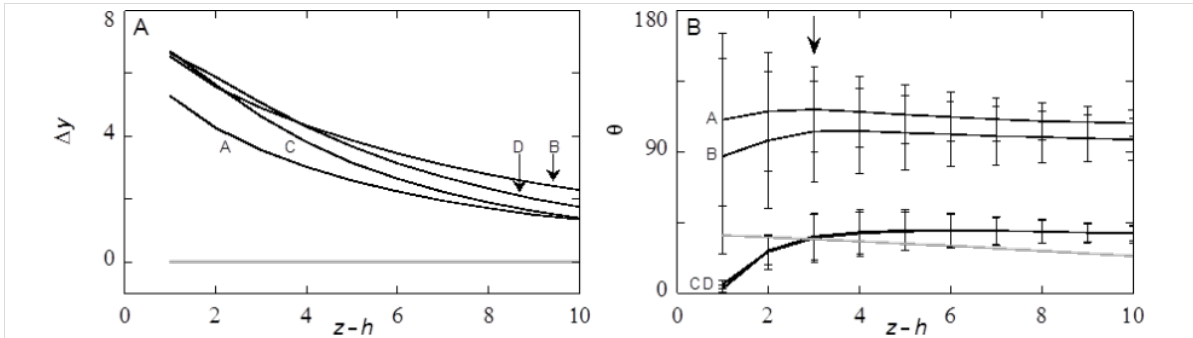
Figure 9: Examples of drop characteristics. A) The standard deviation (measured in x -direction) of the position of the interface Δ y ′ as a function of the height above the substrate z − h . The horizontal grey line represents the result on a smooth surface. B) The angle of the liquid/vapour front in the ( z , y )-plane, θ ( z ) together with the standard deviation of the angle measured in the x -direction plotted as “error” bars. The grey curve is the contact angle of a similarly sized droplet on a smooth surface. The labels A–D correspond to the snapshots A–D in Figure 8: A,B advancing contact liquid front; C,D are receding liquid